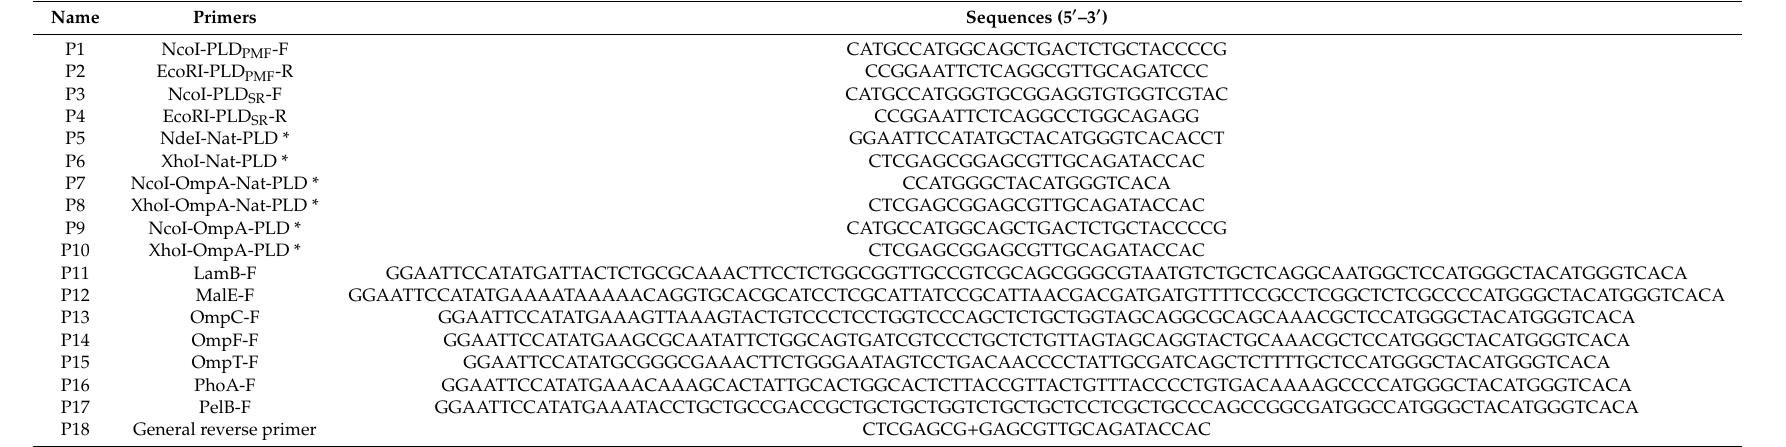
Table 3. Primers used in this